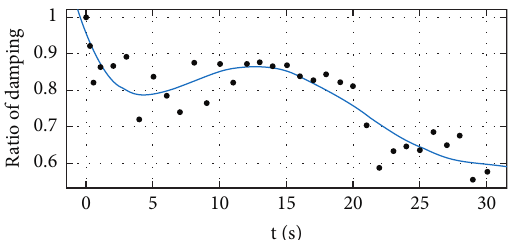
Figure 19: The ratio curve of ballast